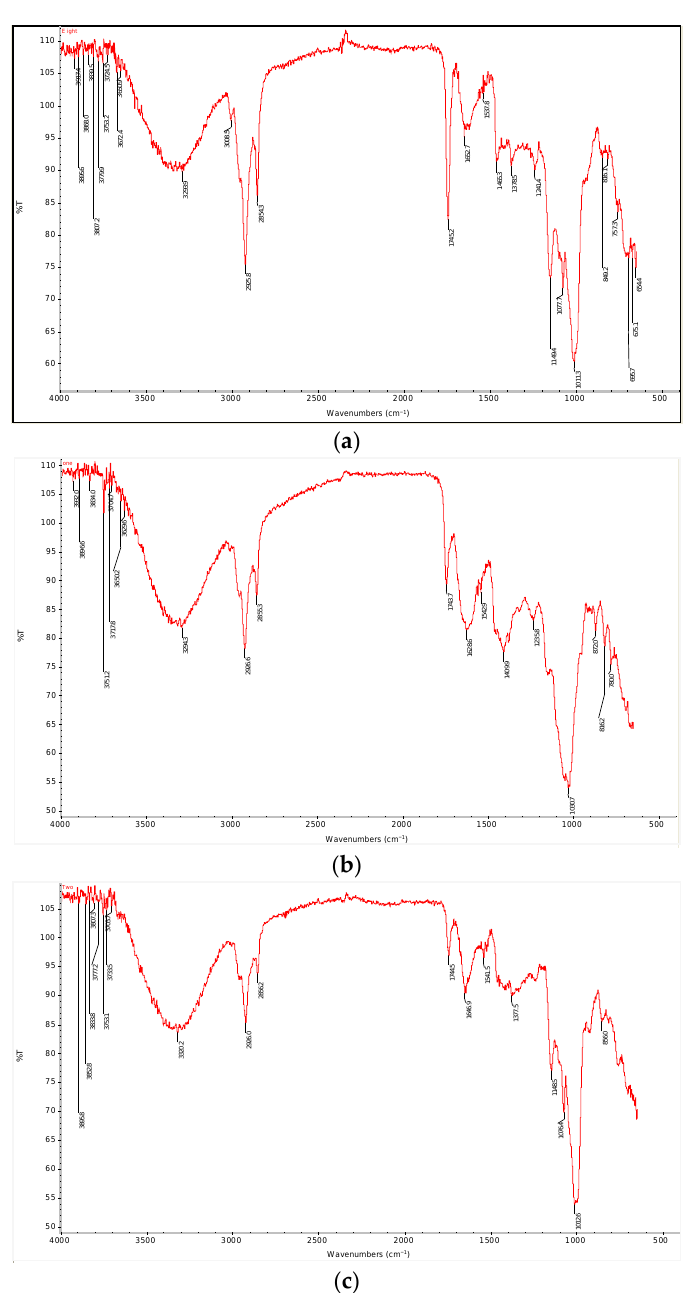
Figure 5. ( a ) FTIR spectrum of finished fried ready-to-cook gluten-free (T3) snack. ( b ) FTIR spectrum of tomato pomace powder. ( c ) FTIR spectrum of finger millet flour.